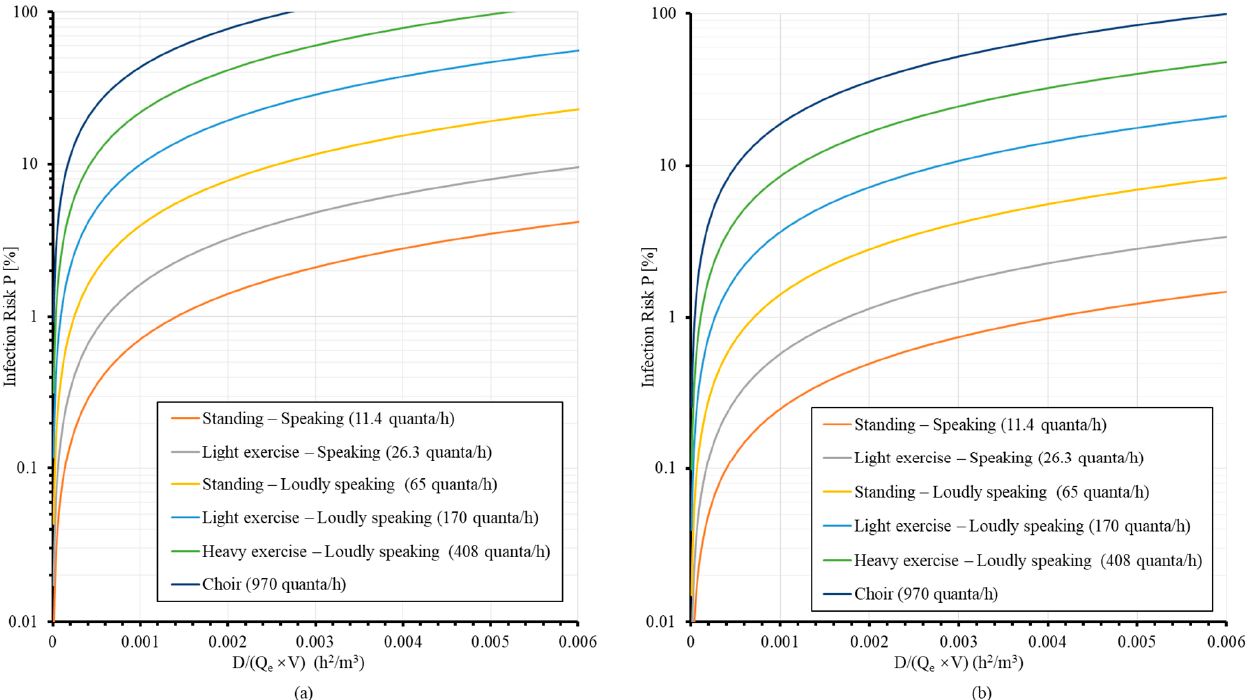
Figure 16. The relationship between individual infection risk and D/(Qe × V), where Qe is Equivalent air change rate (per hour); V is Volume (m 3 ), and D is Duration (h) for ( a ) No masks; ( b ) 100% mask-wearing.